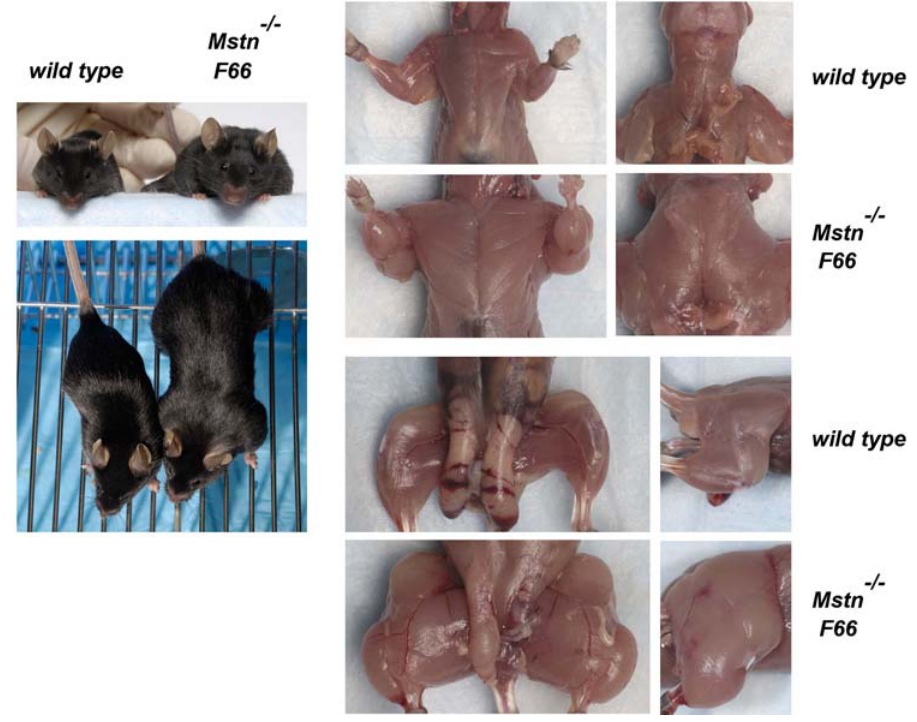
Figure 3. Comparison of wild type and F66/Mstn 2 / 2 mice.